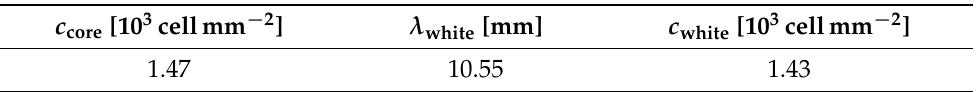
Figure 5. Scatter plot of the surface cell density ( a ) and the extrapolated volume cell density ( b ) versus distance for each available value pairs among white matter voxels (blue dots) with superimposed fitted model curves (red curves). Table 1. Least-squares fitted values of the cell density model parameters in Equation (12) for the surface cell density data plotted in Figure 5a.